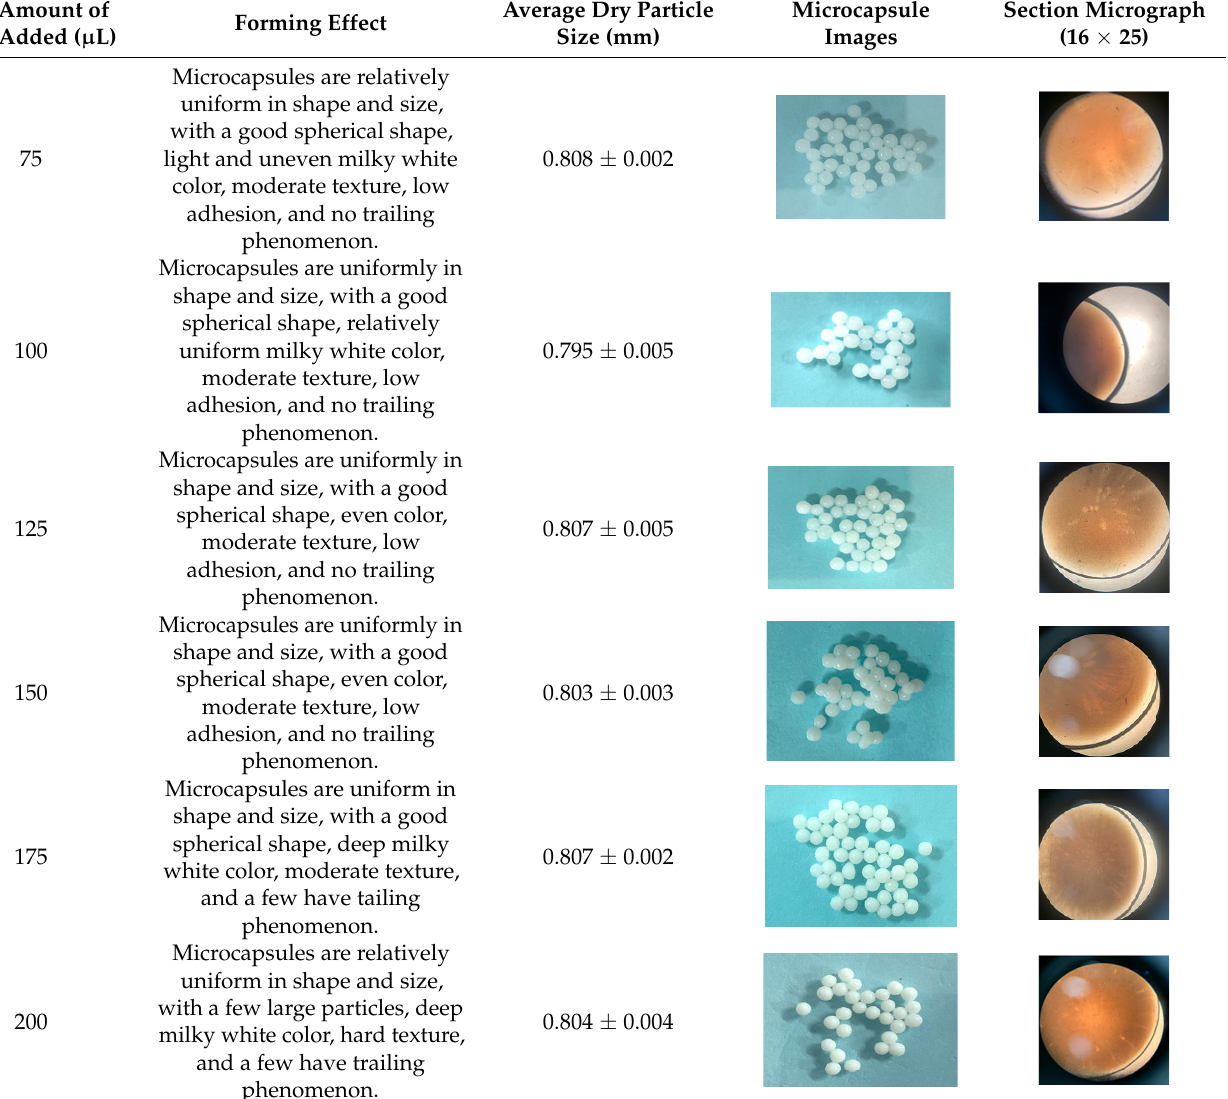
Table 2. Effect of the amount BEOs on microcapsule formation.